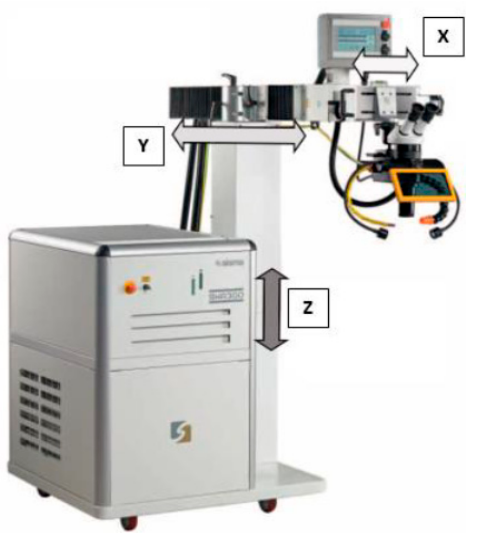
Figure 1. ( a ) SISMA SWA300 Nd:YAG laser welding machine; ( b ) Fixation/support system.